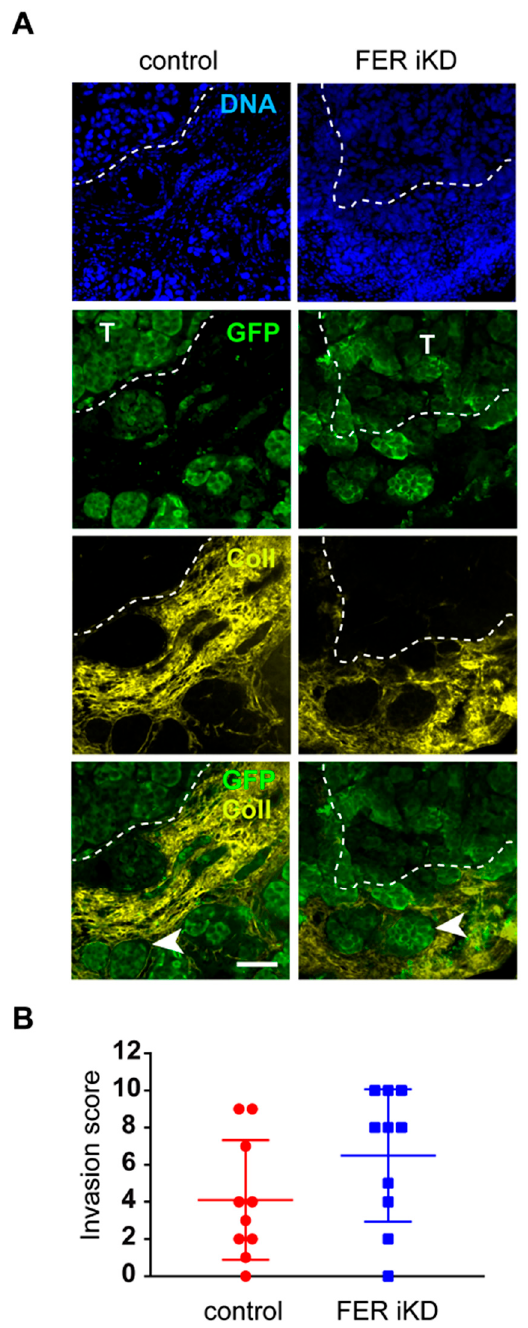
Figure 5. Effect of FER downregulation on melanoma cell invasion. 131/4 ‐ 5B1 control and FER iKD cells were treated with 2 μ g/mL doxycycline for 120 h. Then, cells were suspended in Cultrex and grafted on the chorioallantoic membranes (CAMs) of E11 chicken embryos. On E18, tumors were excised and processed for further analysis. ( A ) Representative sections of control and FER iKD tumors. GFP and collagen III (Coll) antibodies were used to detect melanoma cells and delineate the CAM, respectively. The dotted line outlines the tumor-CAM interface. The arrow indicates tumors cells that have invaded the CAM mesoderm. T: tumor, bar = 100 µ m. ( B ) Ten serial sections from control and FER iKD tumors ( n = 10) were examined. Sections with GFP immunoreactivity within collagen III-positive areas were scored as showing melanoma cell invasion. The dot plot illustrates the invasion scores (number of tumor tissue sections, out of 10, showing invasion).